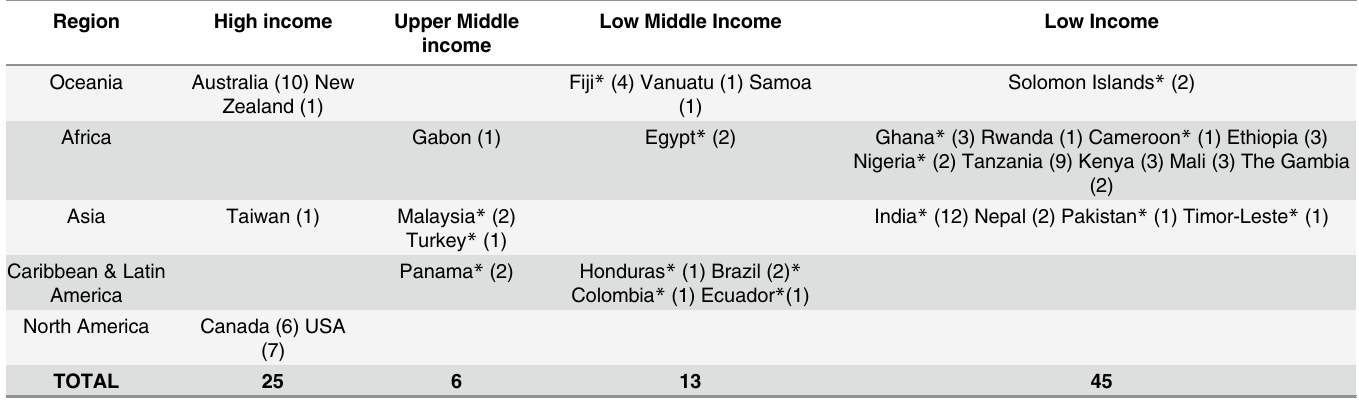
* Category has shifted rather than remaining stable within period from 1987 –